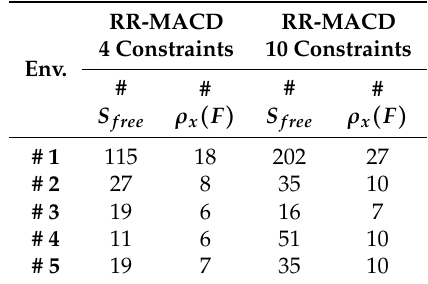
Table 1. 3D path planning results. The number of free-collision voxels within a defined environment is indicated as S free , while the number of discrete 3D nodes built by [44] is denoted by ρ x ( F ) (3D final path).